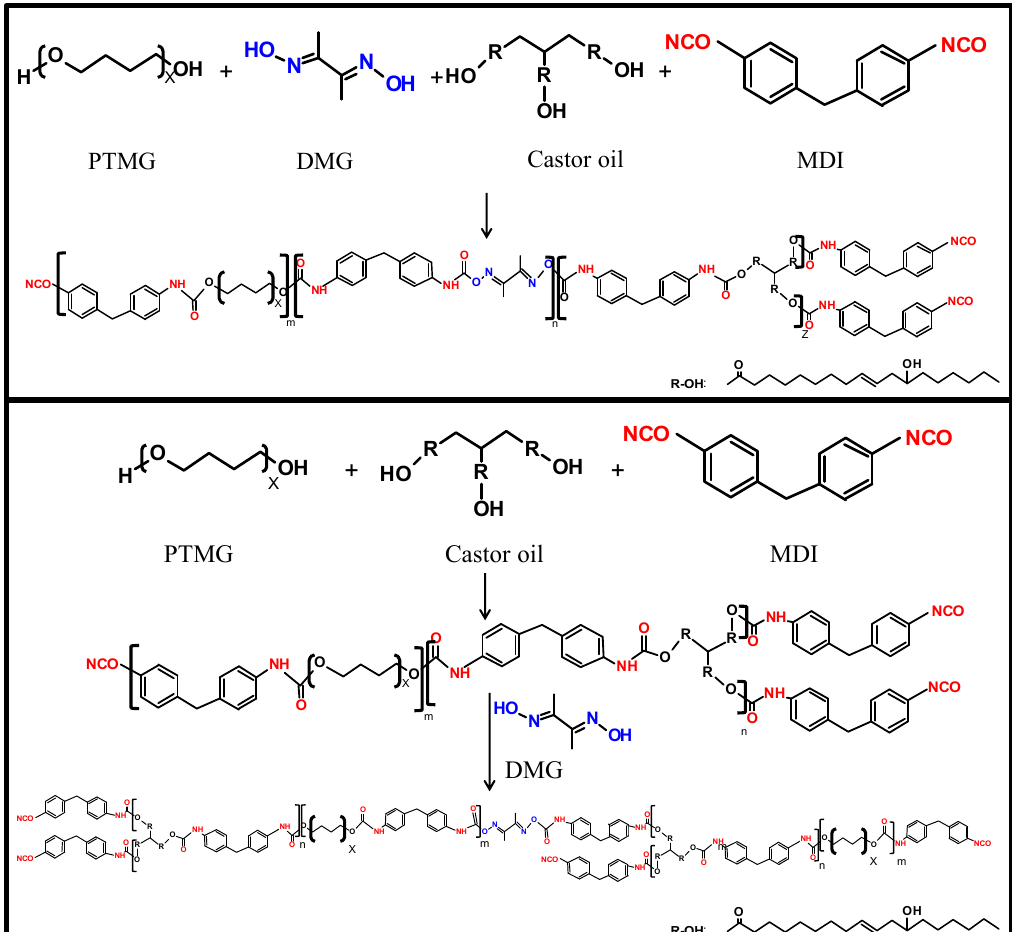
Figure 1 . Reaction pathway of PUR containing castor oil and oxime compounds with various syntheses.